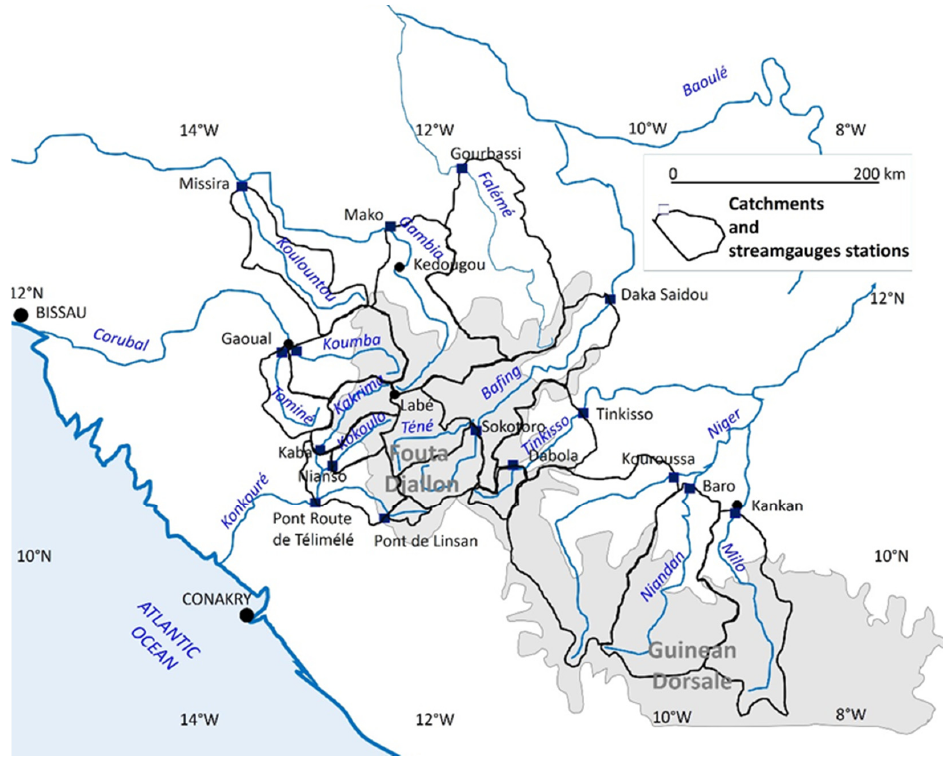
Figure 5. Location of the 16 basins and sub-basins considered in this study.